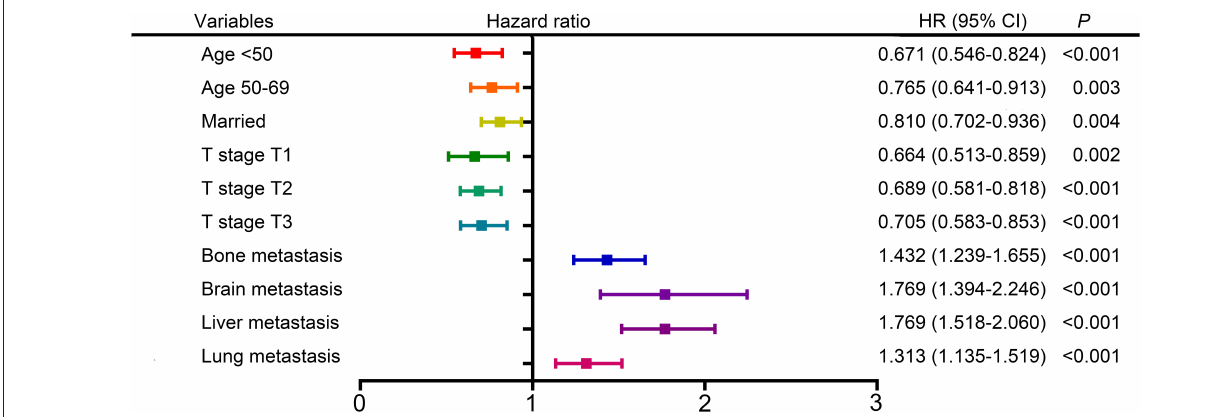
FIGURE 2 | Forest plot showing the results of multivariate analysis for overall survival.